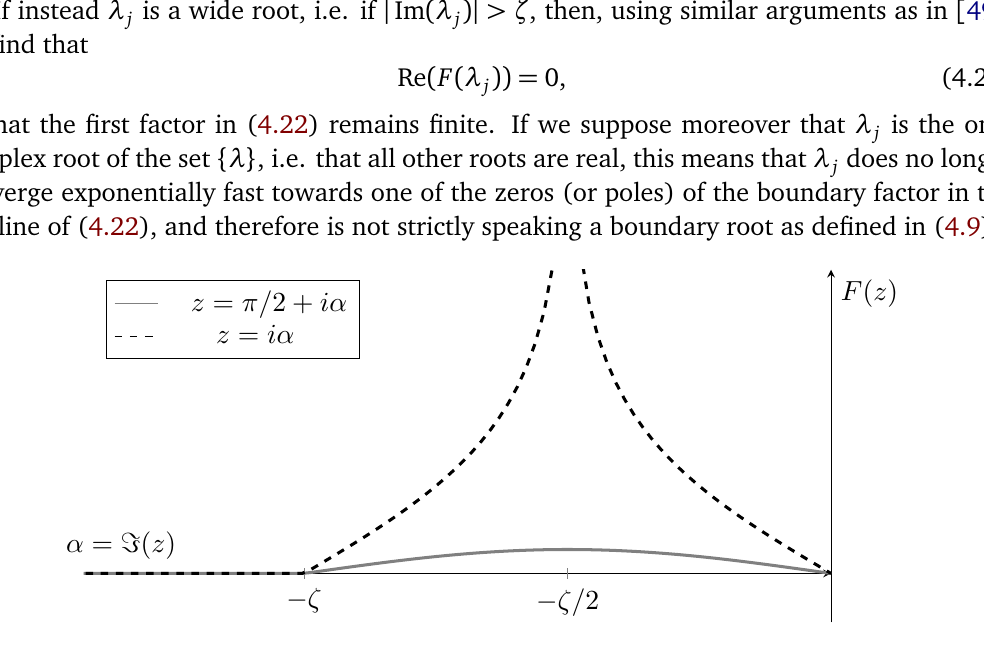
Figure 4: The function F ( z ) (4.23) for values of z = i α (dashed) and z = π/ 2 + i α , (continuous), α <